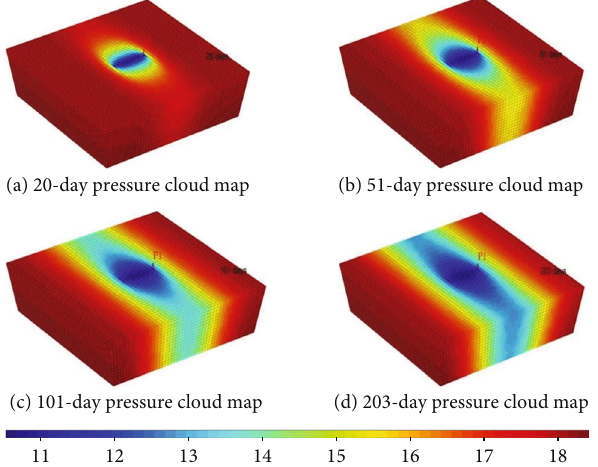
Figure 6: Pressure cloud diagram of horizontal well in anisotropic reservoir at di ff erent production